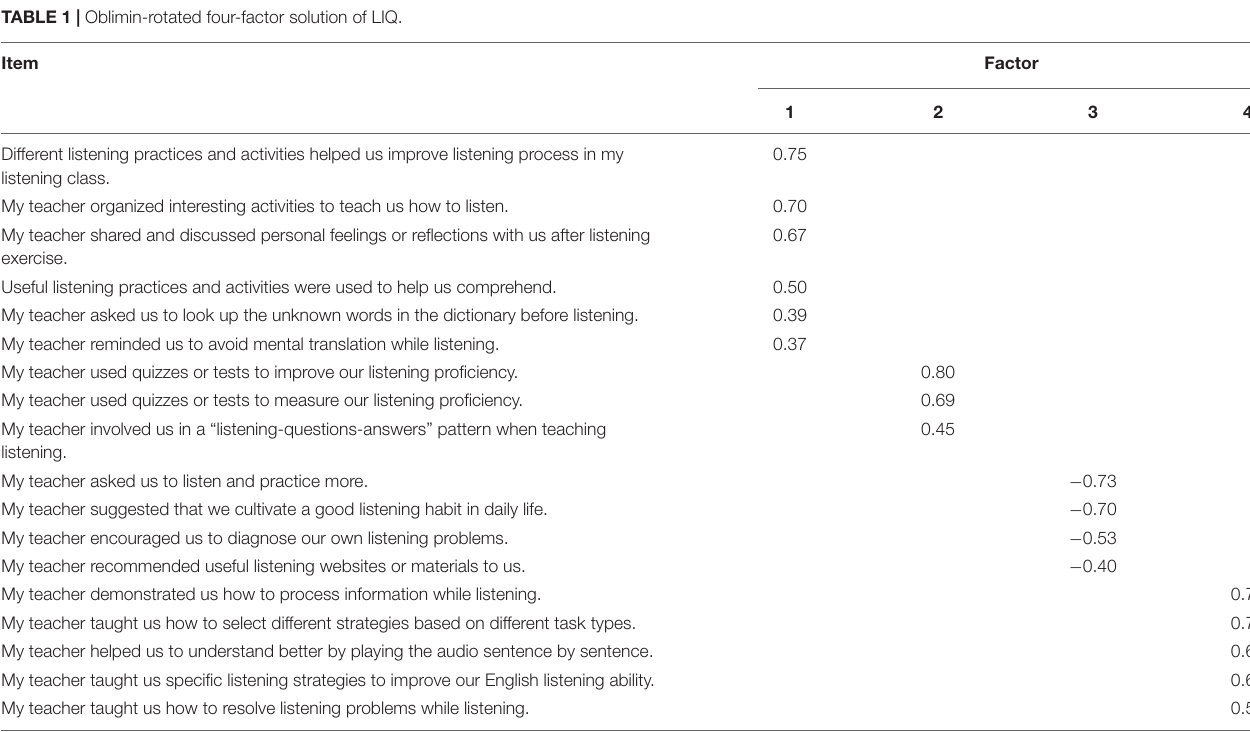
FIGURE 2 | Structural equation model portraying the relationships among the variables in this study. TABLE 1 | Oblimin-rotated four-factor solution of